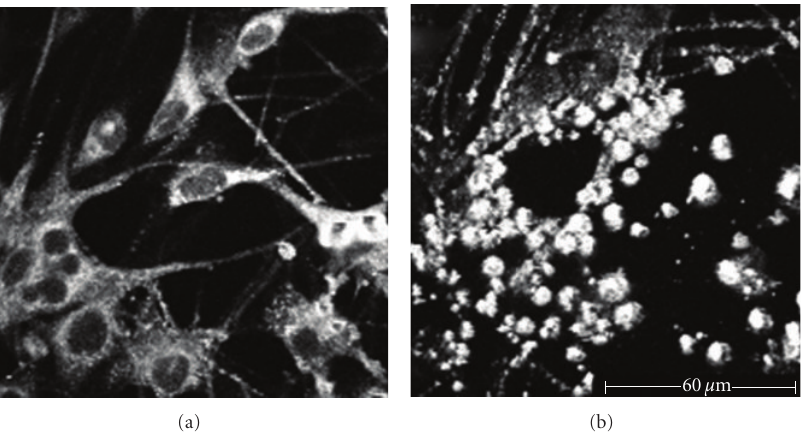
Figure 2: Melanocytes culture. (a) 760 nm excitation wavelength: melanocytes appear as dendritic cells, with a clearly distinguishable cellular body (dark nucleus and fluorescent cytoplasm) and peripheral ramifications. (b) 820 nm excitation wavelength: increasing the excitation wavelength, the cellular body and the dendrites disappear. We can only notice the strong autofluorescence due to melanin granules inside the